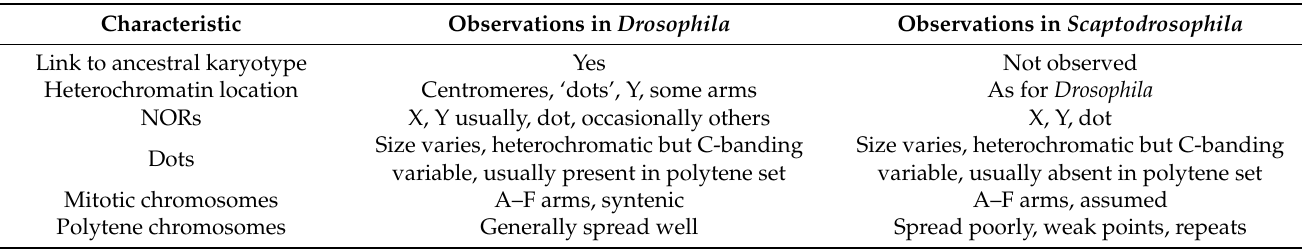
Table 4. Comparison of Scaptodrosophila with Drosophila